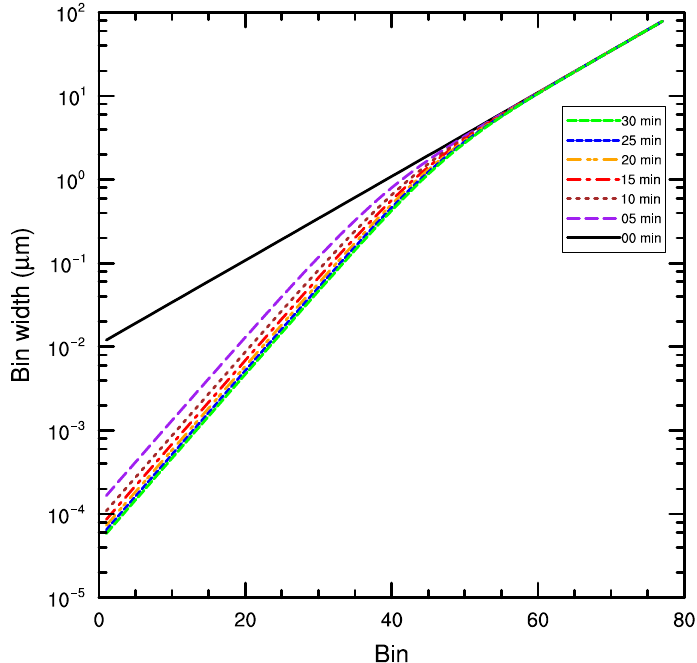
Figure 3. The time evolution of the bin width ( ∆ r i ) in the parcel cloud model with the Lagrangian advection scheme (130 bins).